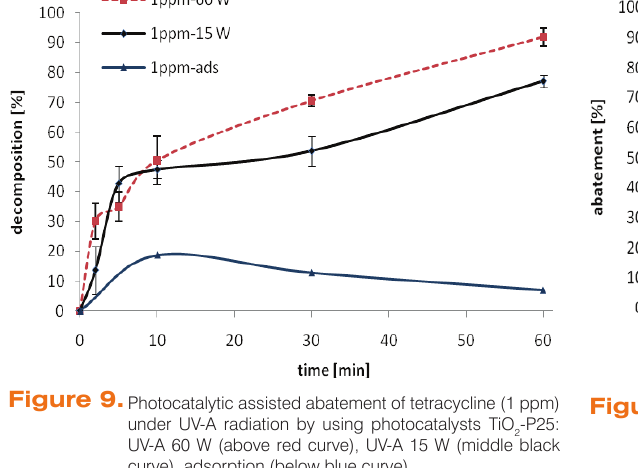
Figure 9. Photocatalytic assisted abatement of tetracycline (1 ppm) under UV-A radiation by using photocatalysts TiO UV-A 60 W (above red curve), UV-A 15 W (middle black curve), adsorption (below blue curve).